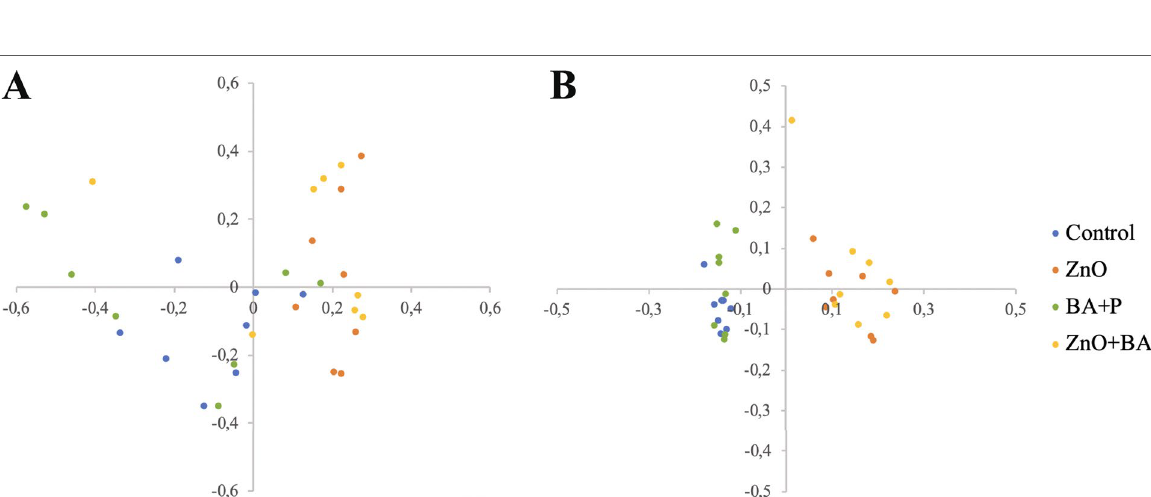
P), ZnO BA P, and without + + +